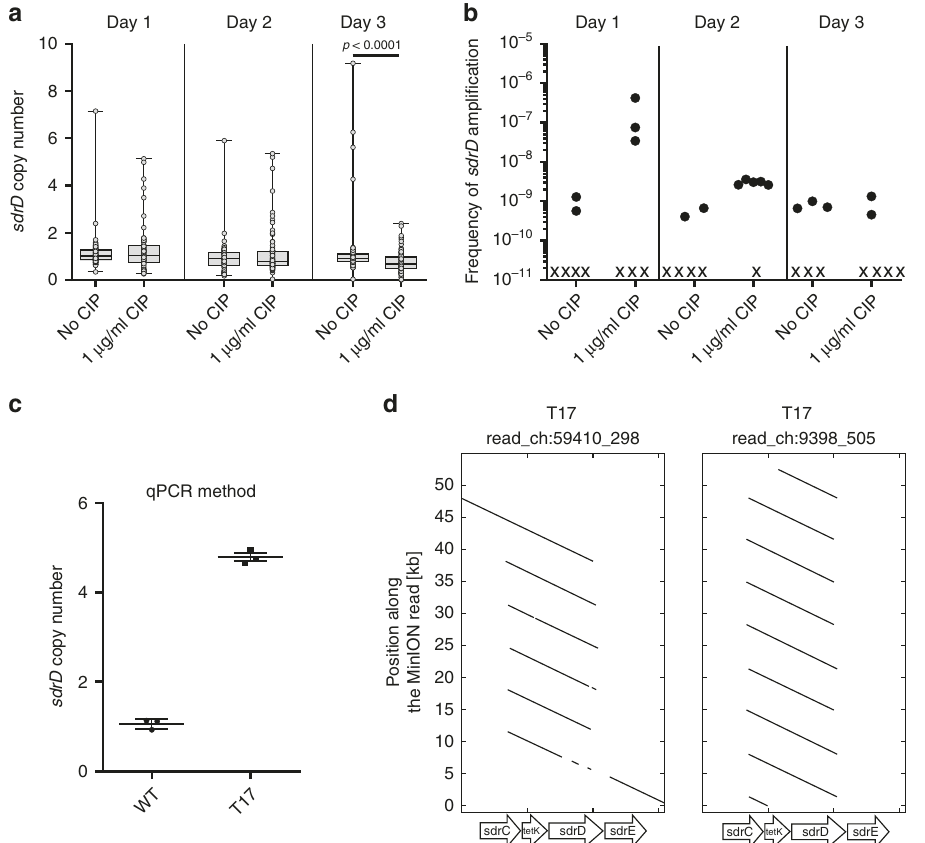
Fig. 4 Tandem ampli fi cation of sdrD :: tetK . a USA300 sdrD::tetK was grown over three consecutive days in six parallel cultures in the presence or absence of cipro fl oxacin (CIP). Each day, the copy number of up to 16 clones of each culture showing high Tc resistance was screened by qPCR. Upper and lower box limits and the horizontal lines within the boxes represent 25 and 75% percentiles and the medians, respectively. The whiskers of the plots indicate minimum and maximum range. Data are derived from six independent experiments and represent: Day 1, n = 87 and n = 76 of “ no Cip ” and “ 1 µ g/ml Cip ” , respectively; Day 2, n = 90 and n = 95 of “ no Cip ” and “ 1 µ g/ml Cip ” , respectively; Day 3, n = 78 and n = 96 of “ no Cip ” and “ 1 µ g/ml Cip ” , respectively. All data points are shown. Datasets were not normal distributed (D ’ Agostino & Pearson omnibus test <0.0001) and statistical analysis was performed using two-tailed Mann – Whitney test. Source data are provided as a Source Data fi le. b Frequency of ampli fi cation (Tc 20 -resistant clones showing at least a 2 fold increase in csa1 copy number compared to the parental strain by qPCR) within the total population of living cells. Shown are the results of six independent experiments. x indicates a culture in which ampli fi cation was not detected. Source data are provided as a Source Data fi le. c sdrD copy number of a high Tc-